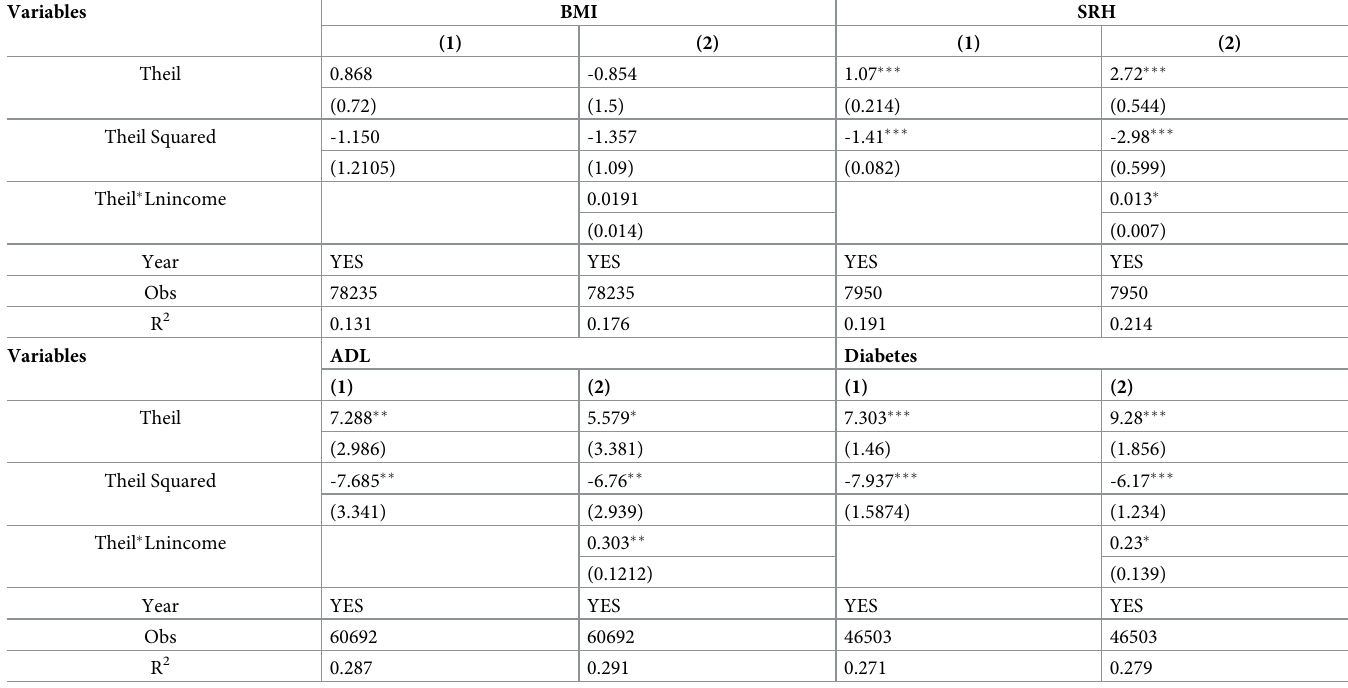
Table 11. Different index—Theil index.